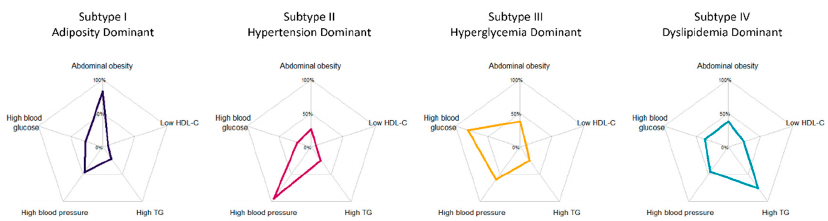
Figure 1. Prevalence of metabolic syndrome components in different subtypes *. * TG, triglyceride; HDL-C, high-density lipoprotein cholesterol.